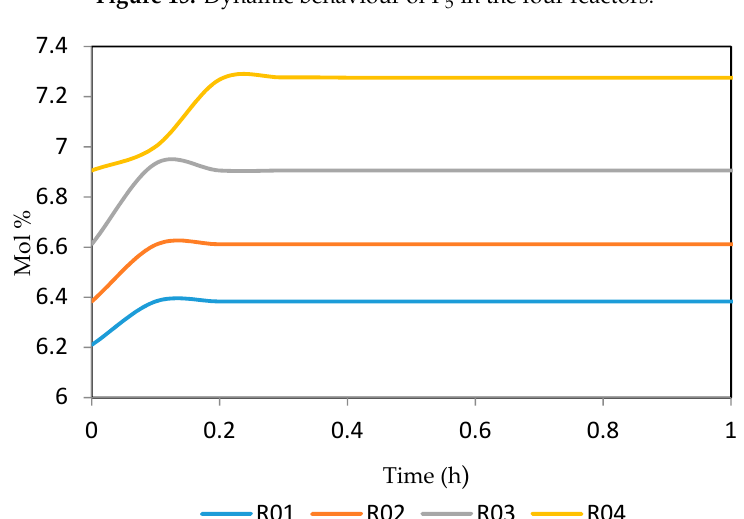
Figure 16. Dynamic behaviour of P 6 in the four reactors.